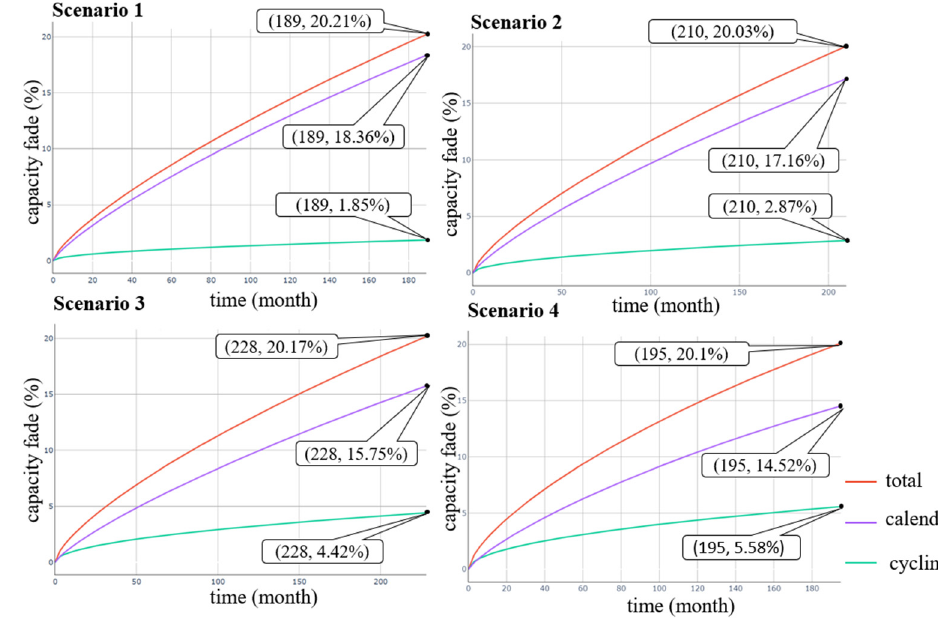
Figure 14. The aging ratio of Scenarios 1 to 4.